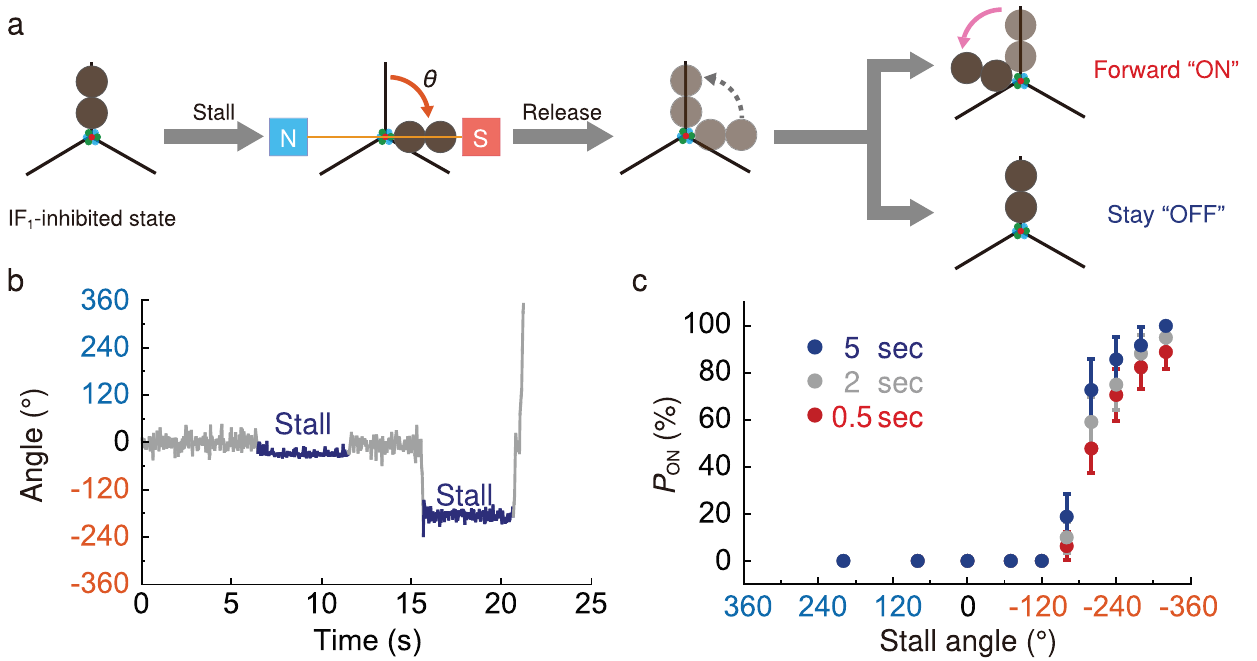
Fig.4|Thestall-and-releaseexperimentofIF 1 -stalled b MF 1 .a Schematicimages ofthemanipulationprocedureinthestall-and-releaseexperiment.When b MF 1 was stalled by IF 1 , the magnetic tweezers were turned on to stall b MF 1 at the target angle. After the set time had elapsed, the magnetic tweezers were turned off, and the molecule returned to the initial angle. Released b MF 1 either resumes its rota- tion(ON)orstaysattheinitialposition(OFF).Thesebehaviorsindicatewhetheror not IF 1 dissociates from b MF 1 under the stalling time. b A representative time course of the stall-and-release experiment under 100 μ M ATP, 100 μ M ADP, and 1mMP i inthepresenceof3 μ MIF 1 .Inthis fi gure,thestalltimeforbothtrials(blue) was5sandthestallangleswere-26°and-168°,respectively. c Angledependenceof